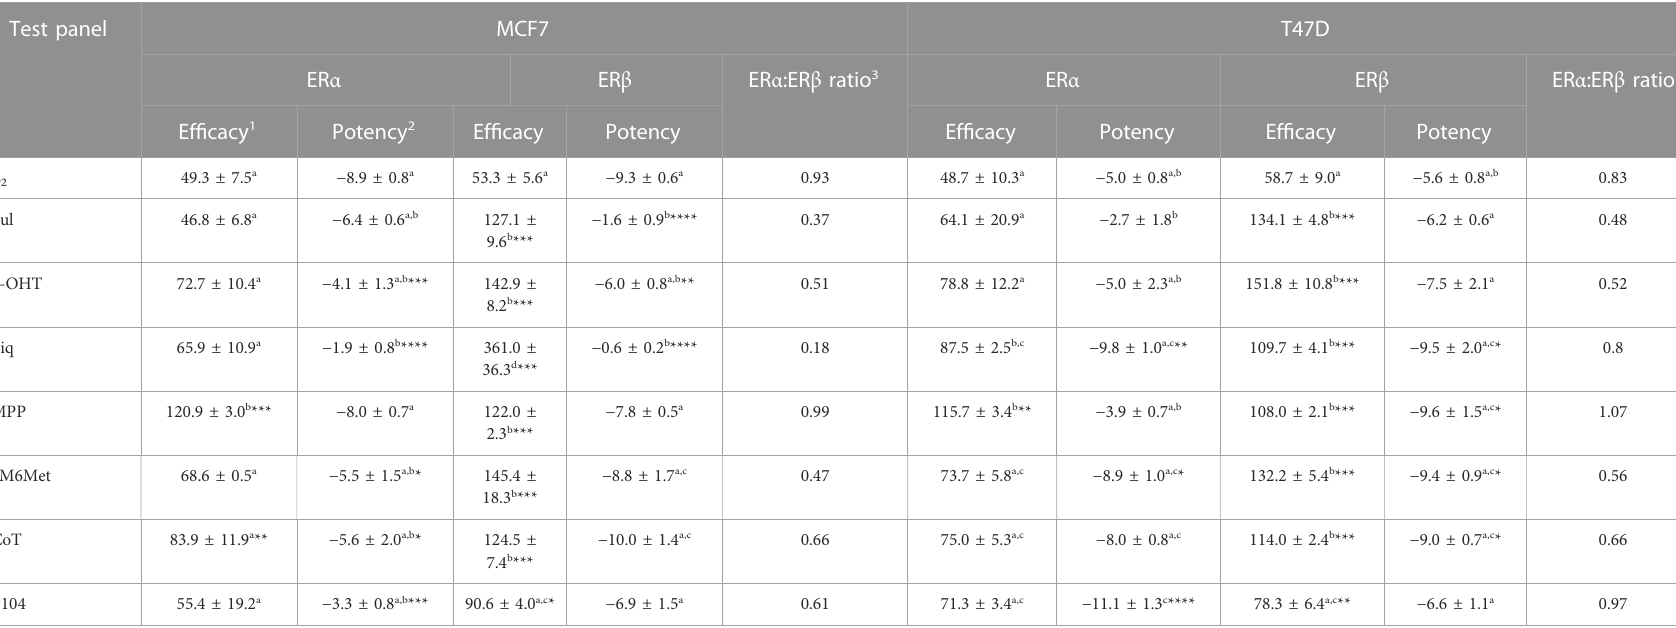
TABLE 2 Ef fi cacy and potency of the test compounds and Cyclopia extracts in modulating ER α and ER β protein levels in MCF7 and T47D cells. Test